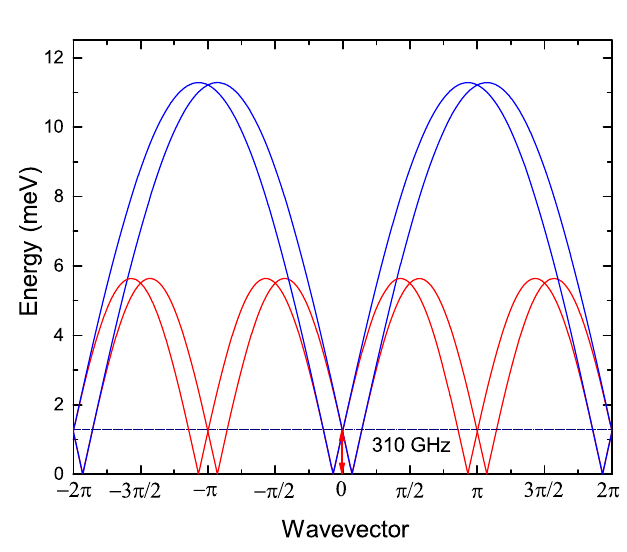
Fig.6|Two-spinoncontinuumcalculatedforan S = 1 J / k B =41.7KandtheuniformDMI D / k B =9.47K. Theupperandlowerboundaries of the two-spinon continuum are denoted by the blue and red lines, respectively. The gap observed at the Γ point, Δ =310 GHz, is shown by the